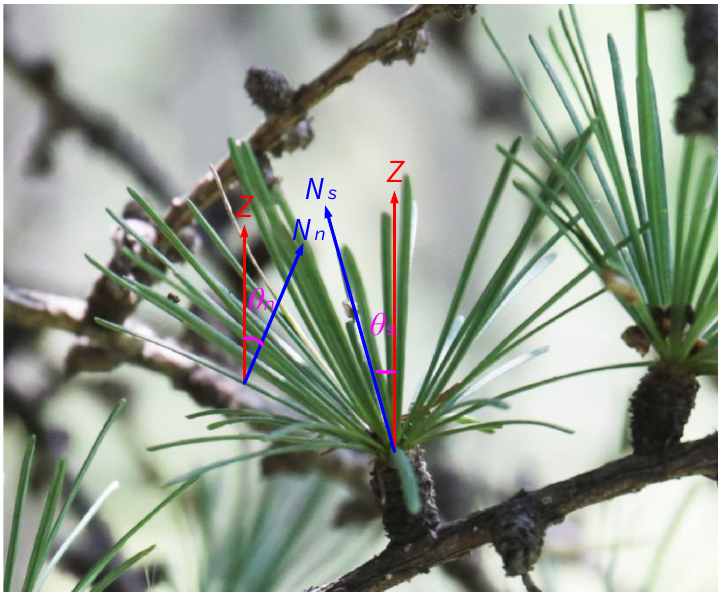
Figure 1. Example of the determination of the needle or shoot inclination angles based on the leveled digital photography method. Here, 𝑍 denotes the zenith, 𝑁 𝑛 denotes the needle surface normal, and 𝑁 𝑠 denotes the major axis of the cylindrical shoot brachyplast; 𝜃 𝑛 and 𝜃 𝑠 are the needle and shoot inclination angles, respectively.